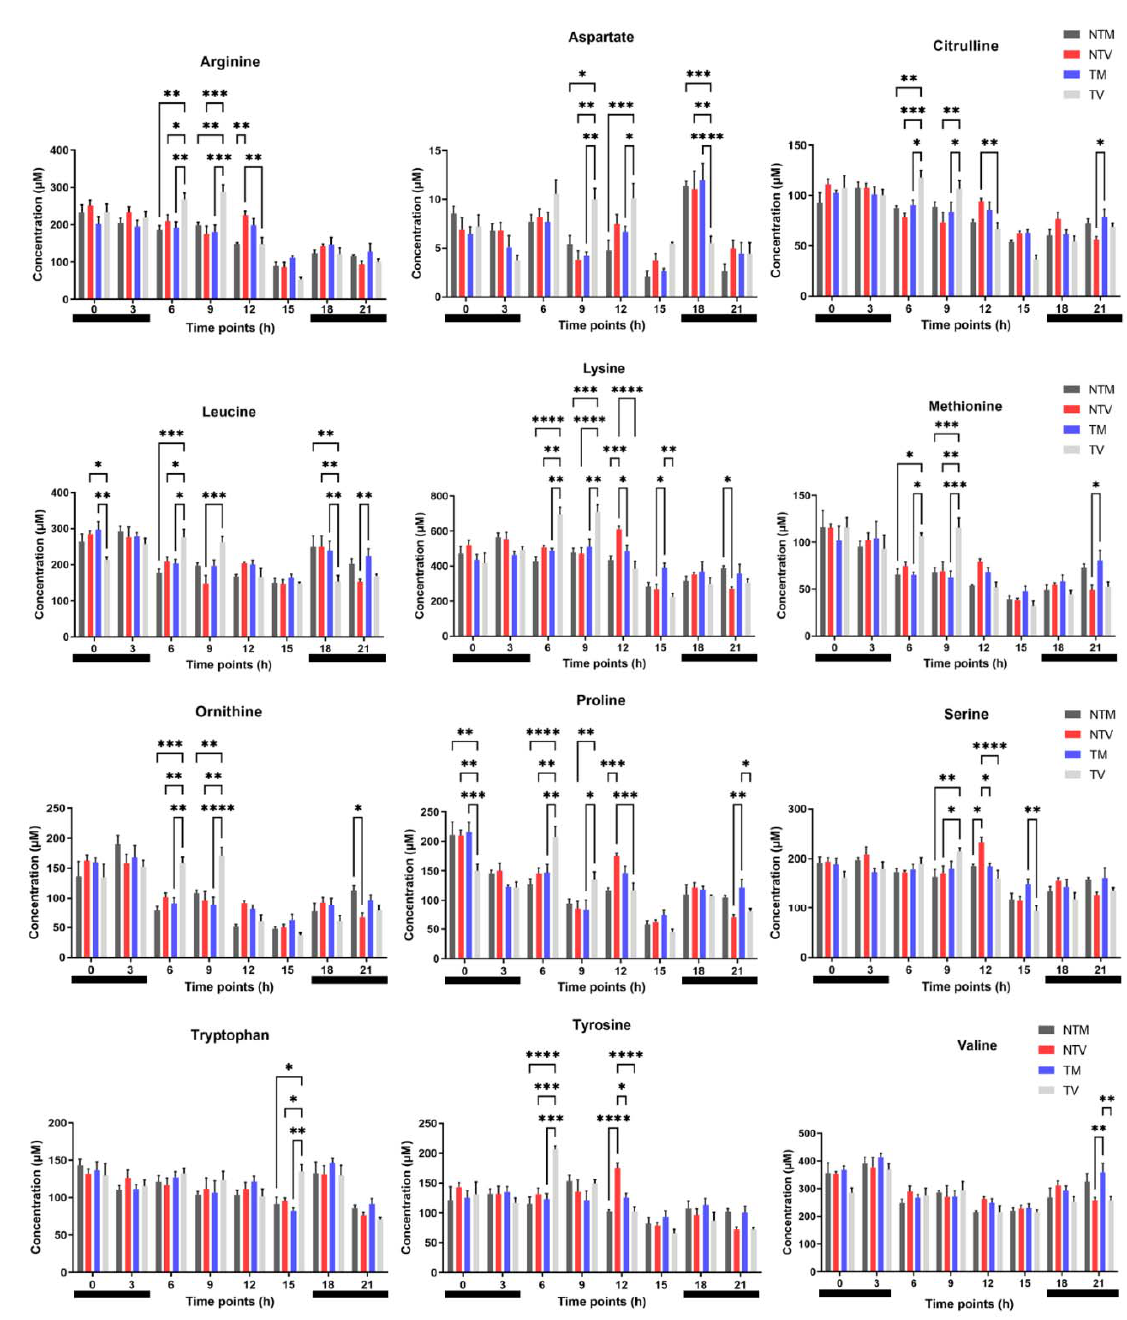
Figure 2. Concentrations of plasma amino acids in BC-bearing mice. The amino acids were measured at eight time points after treatment with melatonin or vehicle only. Light phase included 06:00, 09:00, 12:00, and 15:00 and dark phase included 18:00, 21:00, 00:00, and 03:00 (horizontal black bars). Data represent the mean ± SD of the concentrations ( µ M) among the experimental groups (NTM: non-tumor treated with melatonin; NTV: non-tumor treated with vehicle; TM: tumor treated with melatonin; TV: tumor treated with vehicle). Two-way ANOVA complemented with Tukey’s multiple comparisons test. * p < 0.05, ** p < 0.01, *** p < 0.001, **** p <